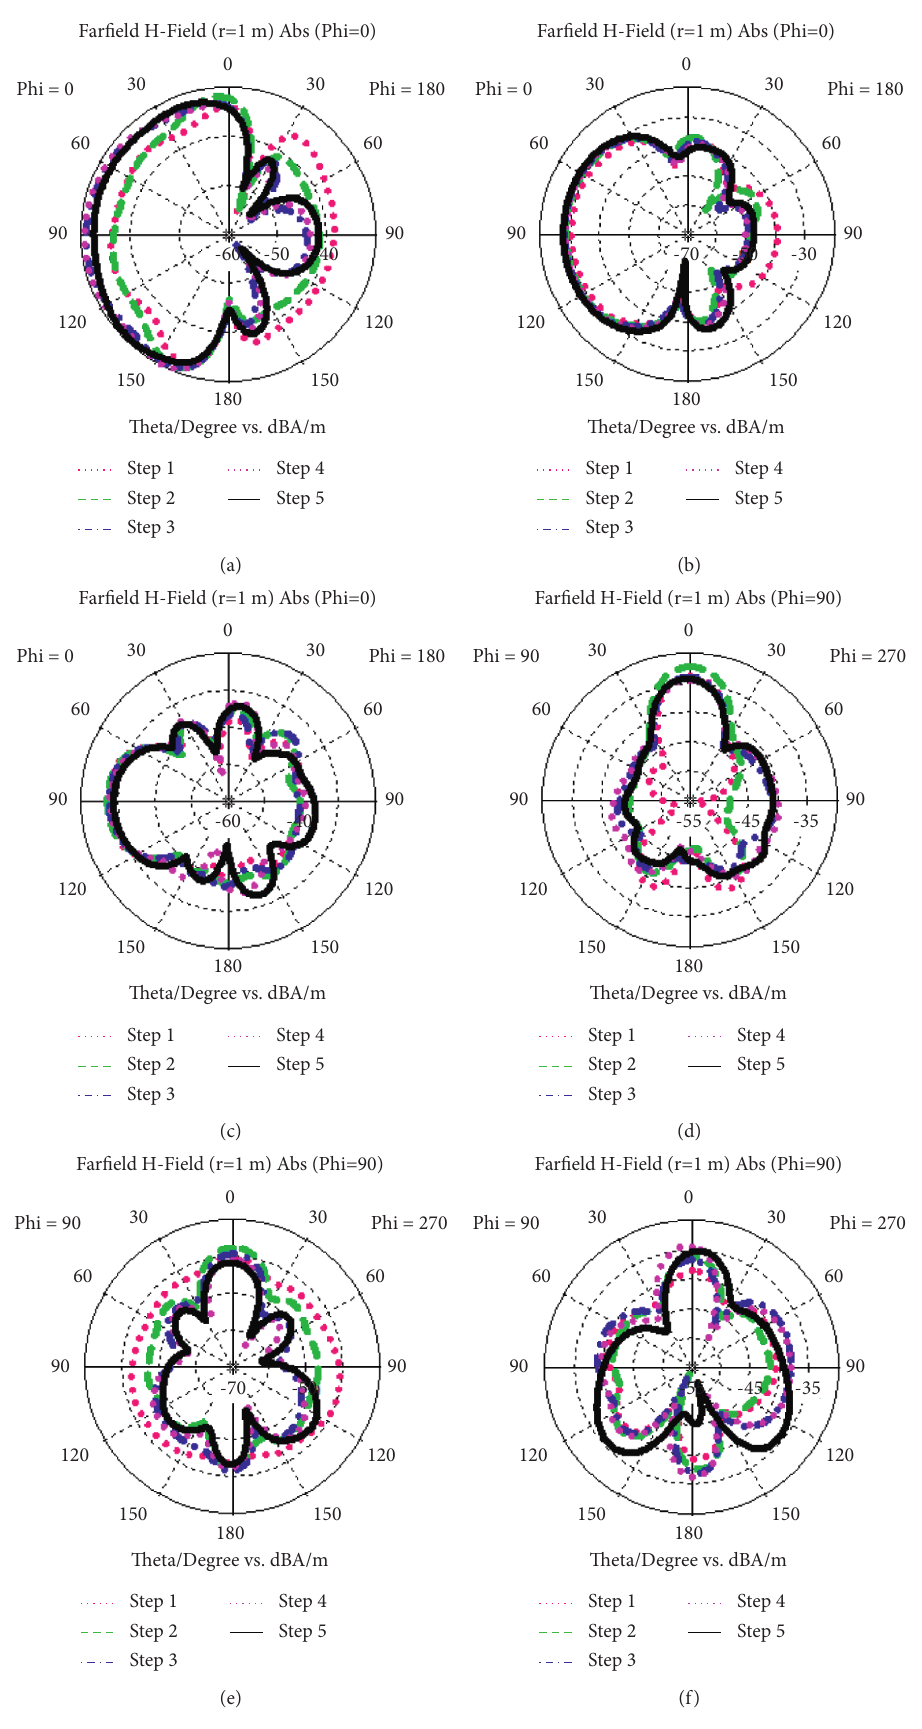
Figure 13: Magnetic field (H-field) for all the steps at Phi � 0 ° and 90 ° : (a) H-field (Phi � 0 ° ; 3.81GHz); (b) H-field (Phi � 0 ° ; 6.75GHz); (c) H- field (Phi � 0 ° ; 13.86 GHz); (d) H-field (Phi � 90 ° ; 3.81GHz); (e) H-field (Phi � 90 ° ; 6.75GHz); (f) H-field (Phi � 90 ° ; 13.86